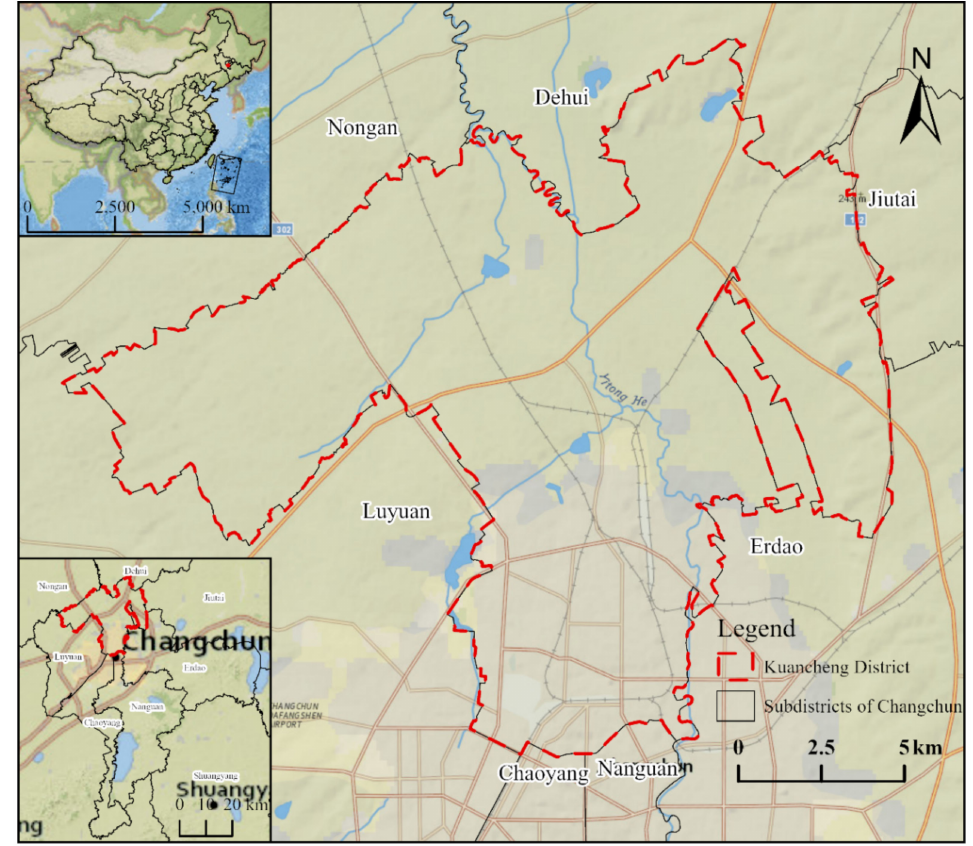
Figure 1. Location of Kuancheng